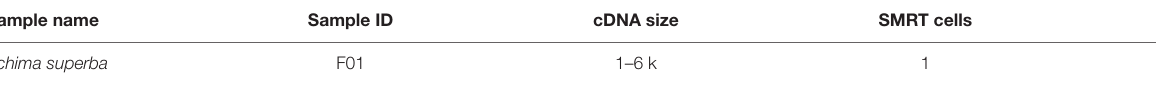
TABLE 2 | Reads summary insert from single molecule long-read sequencing.